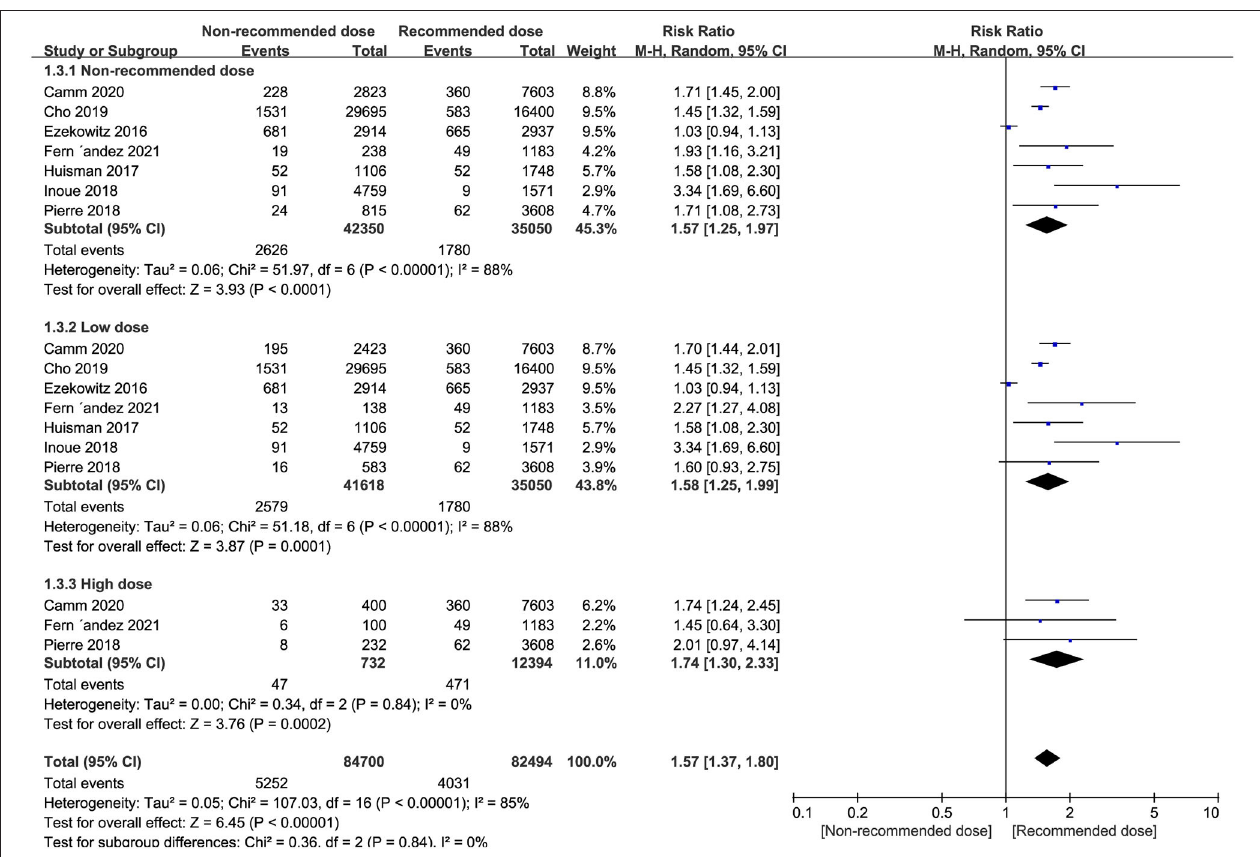
FIGURE 4 | Forest plot for all-cause mortality in non-recommended dose compared to recommended dose of NOACs. NOACs, new oral anticoagulants.